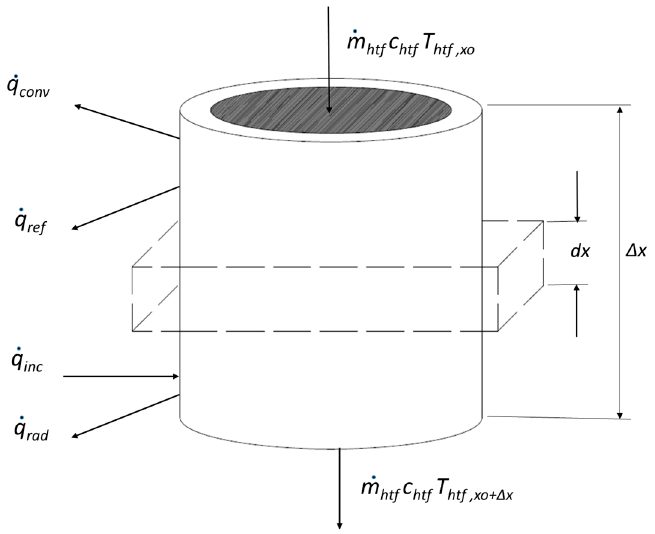
Figure 2. Energy balance of the external receiver.